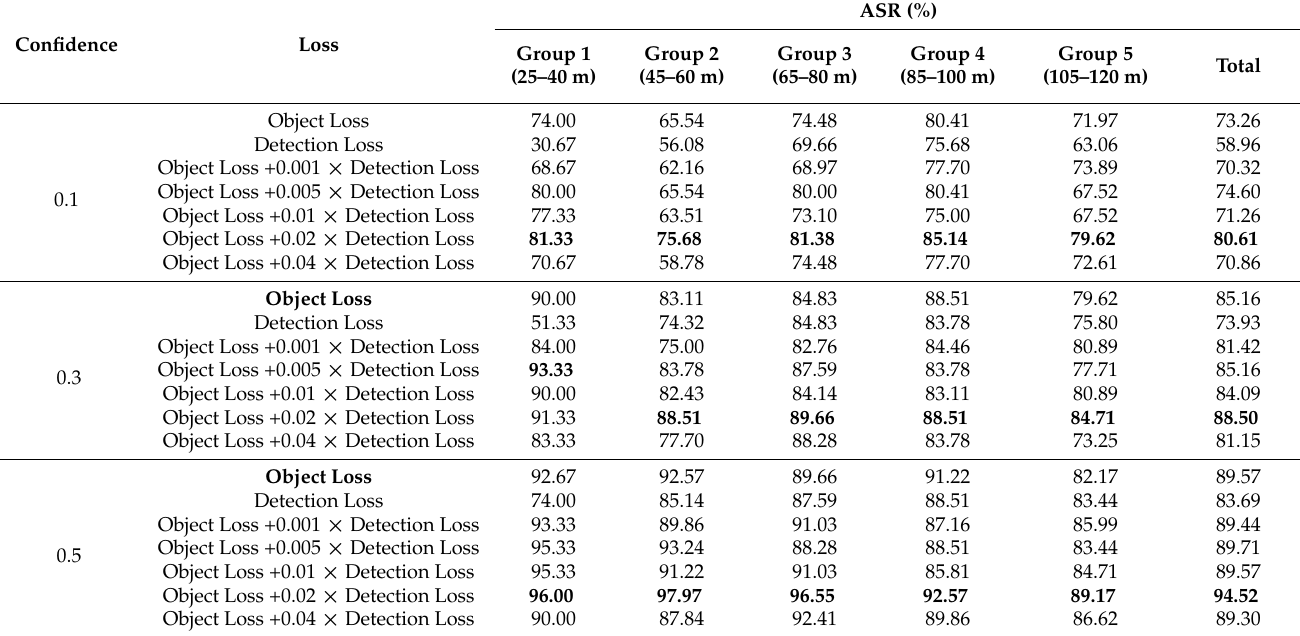
Table 5. Experimental results of different loss items for Yolo-V3. Bold fonts indicate the best effect.